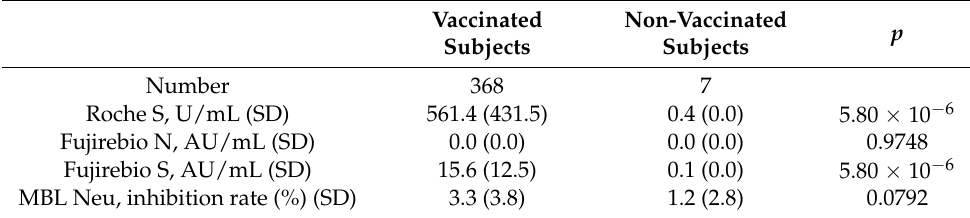
Table 1. SARS-CoV-2 Ab titers.